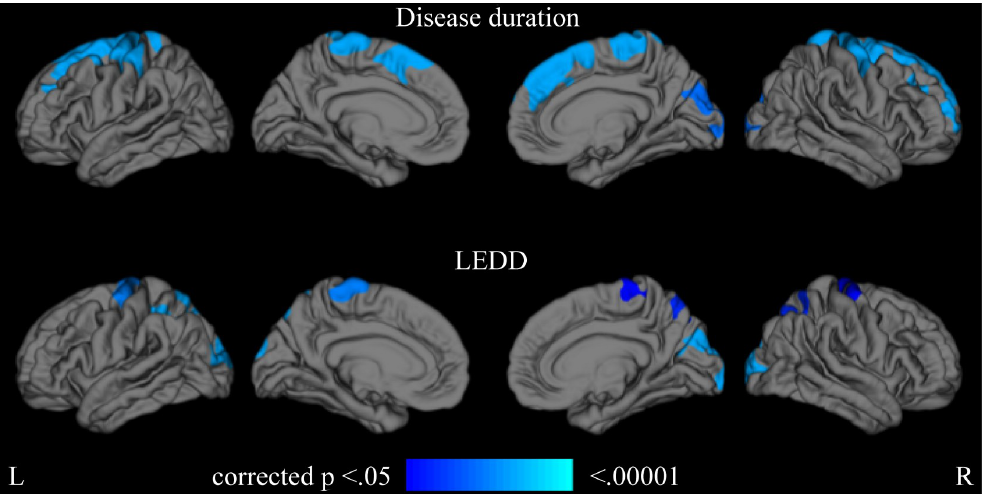
Fig 1. Areas of cortical thinning with disease progression in all patients. Color maps indicate areas with significant thinning (p < 0.05). LEDD, levodopa equivalent daily